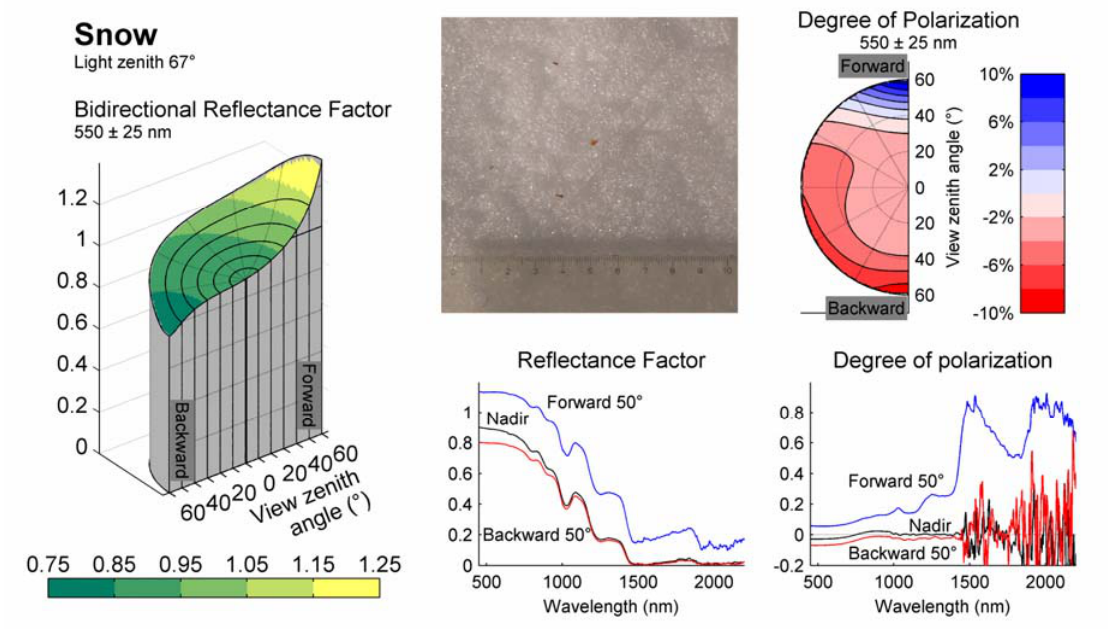
Figure 8. Reflectance properties of a snow sample at 67° illumination zenith